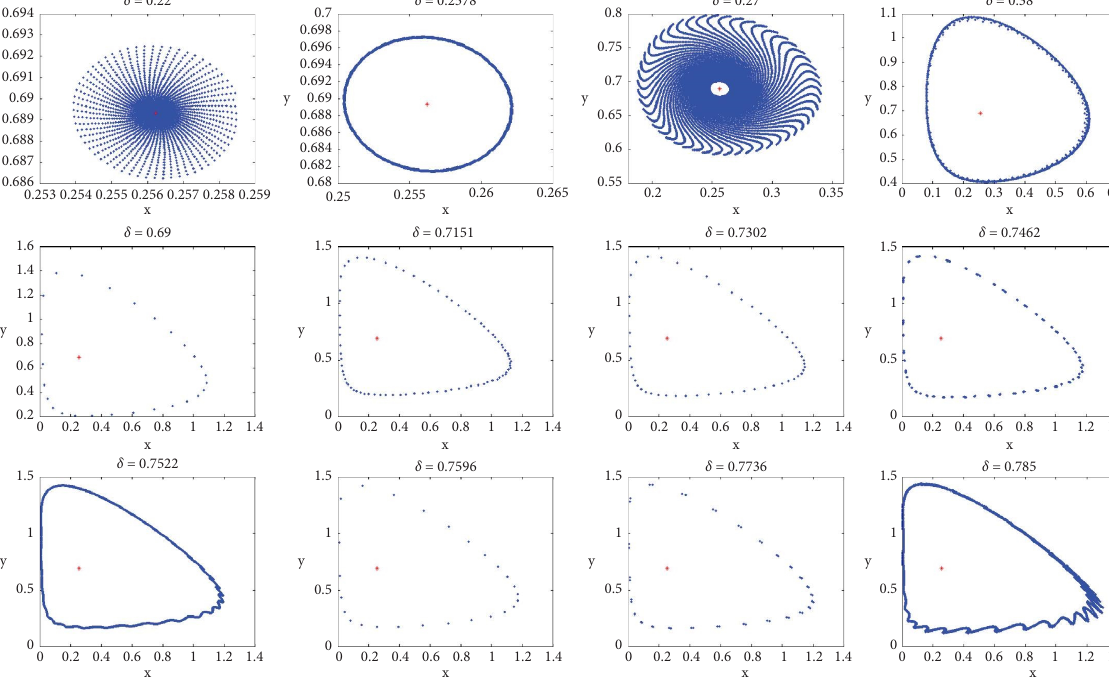
Figure 5: Phase portraits (in xy -plane) for diferent values of δ connected to Figures 4(a) and